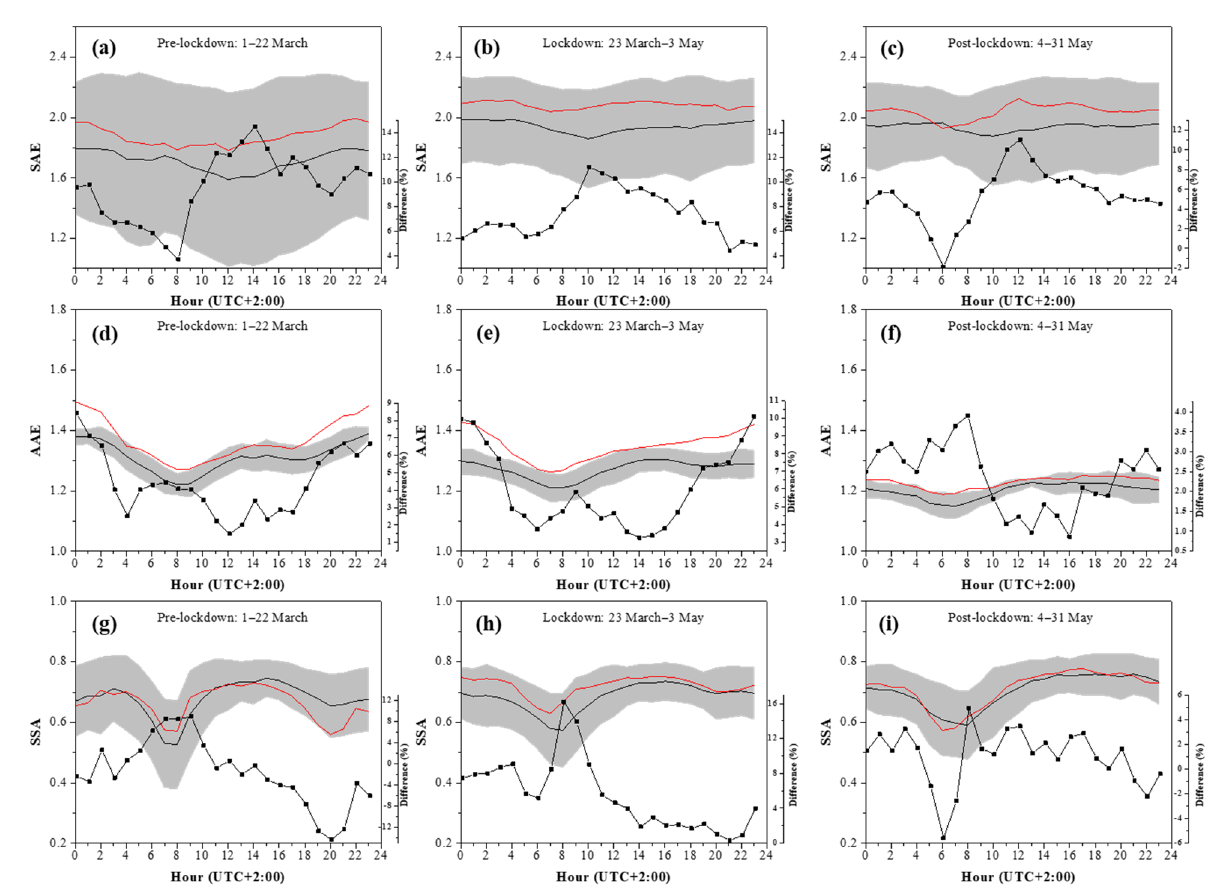
Figure 7. Mean diurnal variation of SAE 450-700 ( a – c ), AAE 470-950 ( d – f ) and SSA 520 ( g – i ) for periods pre-, post- and during the lockdown. Red line corresponds to 2020, while the black line represents the mean for the years 2017–2019 for SAE and SSA and 2016–2019 for AAE. The shaded area corresponds to one standard deviation from the hourly mean during 2016–2019 and/or 2017–2019. The percentage (%) differences in SAE (scattering Angström exponent), AAE (absorption Angström exponent) and SSA (single scattering albedo) between the examined periods in 2020 and the mean of previous years are also shown.